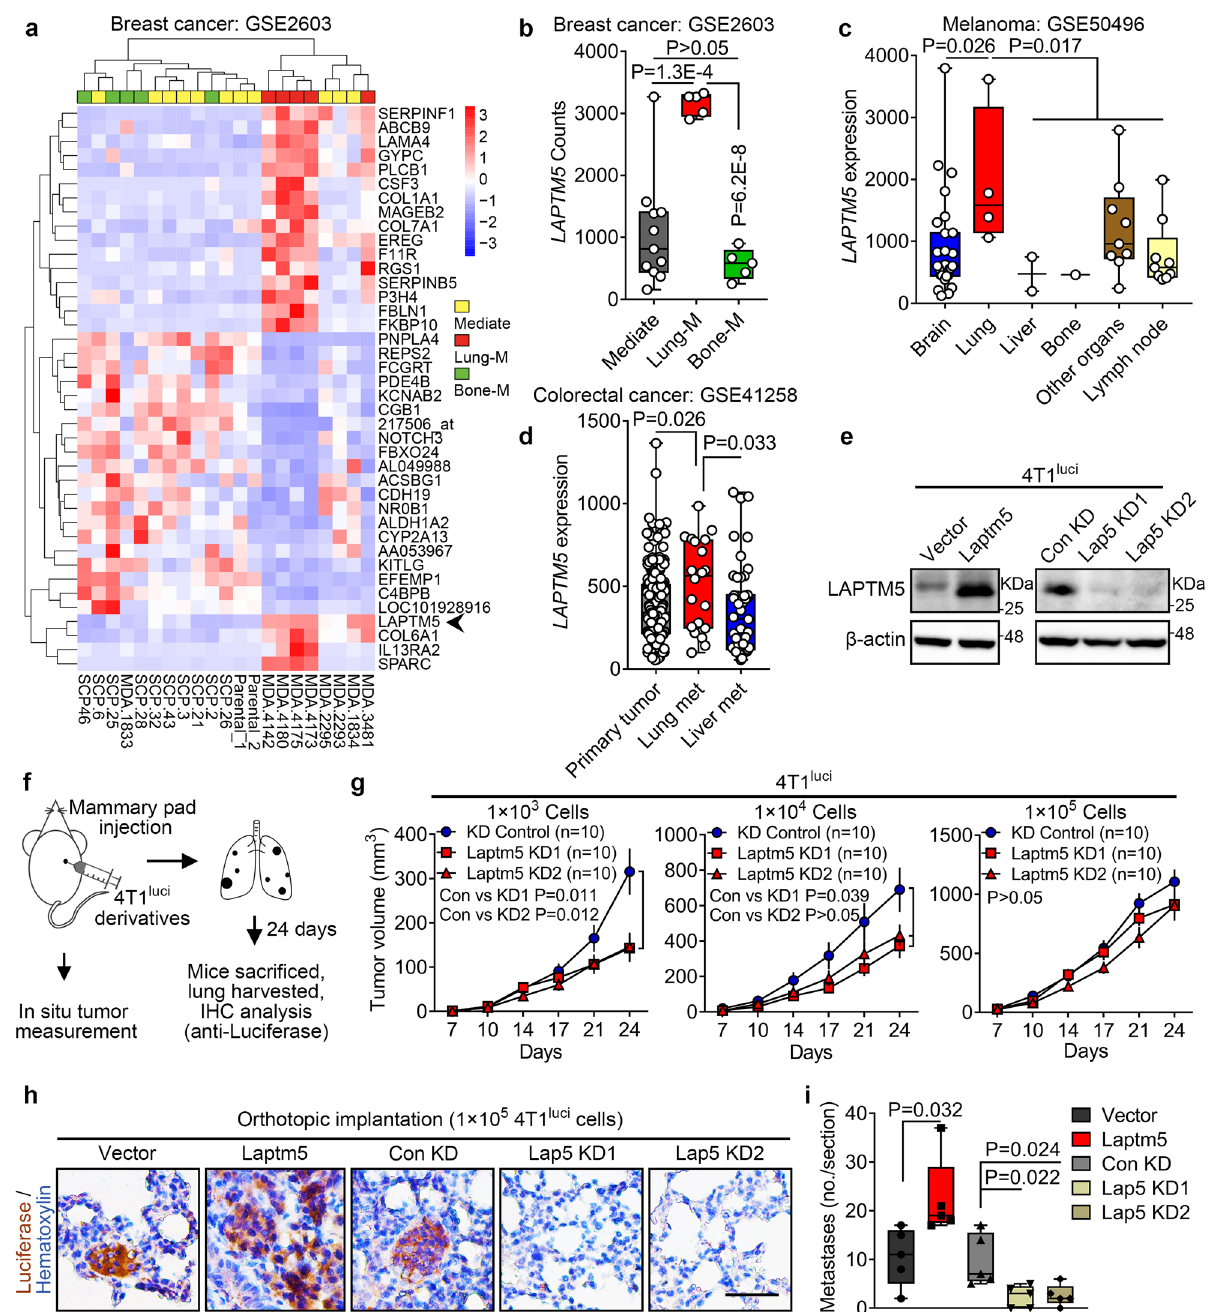
Fig. 8 LAPTM5 is speci fi cally activated in lung metastases of multiple cancers. a Double clustering heatmap of top 20 up- and down-regulated genes in breast cancer (BCa) cells with lung metastatic activity (Lung-M, n = 5 cell lines) compared with populations with mediate activity (Mediate, n = 11 cell lines) and bone metastatic activity (Bone-M, n = 5 cell lines) in the GSE1206 dataset. b LAPTM5 counts in BCa cells with mediate (Mediate, n = 11), lung metastatic (Lung-M, n = 5) and bone metastatic (Bone-M, n = 5) activity in the GSE1206 dataset. c LAPTM5 expression in brain ( n = 27 samples), lung ( n = 4 samples), liver ( n = 2 samples), bone ( n = 1 sample), other organs ( n = 9 samples) and lymph node ( n = 9 samples) metastases from melanoma in the GSE50496 dataset. d LAPTM5 expression in primary tumors (n = 186 samples), lung ( n = 20 samples) and liver ( n = 47 samples) metastases from colorectal cancer in the GSE41258 dataset. e IB analysis of control and Laptm5-overexpressing or control and Laptm5-silenced 4T1 luci cells. Immunoblots are representative of three biological replicates. f Schematic illustration for the mammary pad cell inoculation, in situ tumor measurement and lung metastases detection using the murine 4T1 breast cancer cell line. g Tumor volumes of control and Laptm5-silenced 4T1 luci cells inoculated in situ as described in ( f ). n = 10 mice per group. The data represent the mean ± SEM. h Representative IHC images of luciferase staining in lung sections harvested from mice treated as in ( f ). Scale bar, 50 μ m. i Quanti fi cation of metastases per lung section at 24 days after mammary pad injection in each group ( n = 5 mice per group). In b , c , d , and i , the data are presented as whisker plots: midline, median; box, 25 – 75th percentile; whisker, minimum to maximum values. Two-tailed Student ’ s unpaired t -test was used for statistical analysis in all panels. Source data are provided as a Source data fi